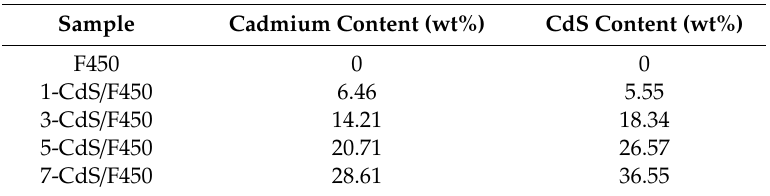
Table 1. ICP data of